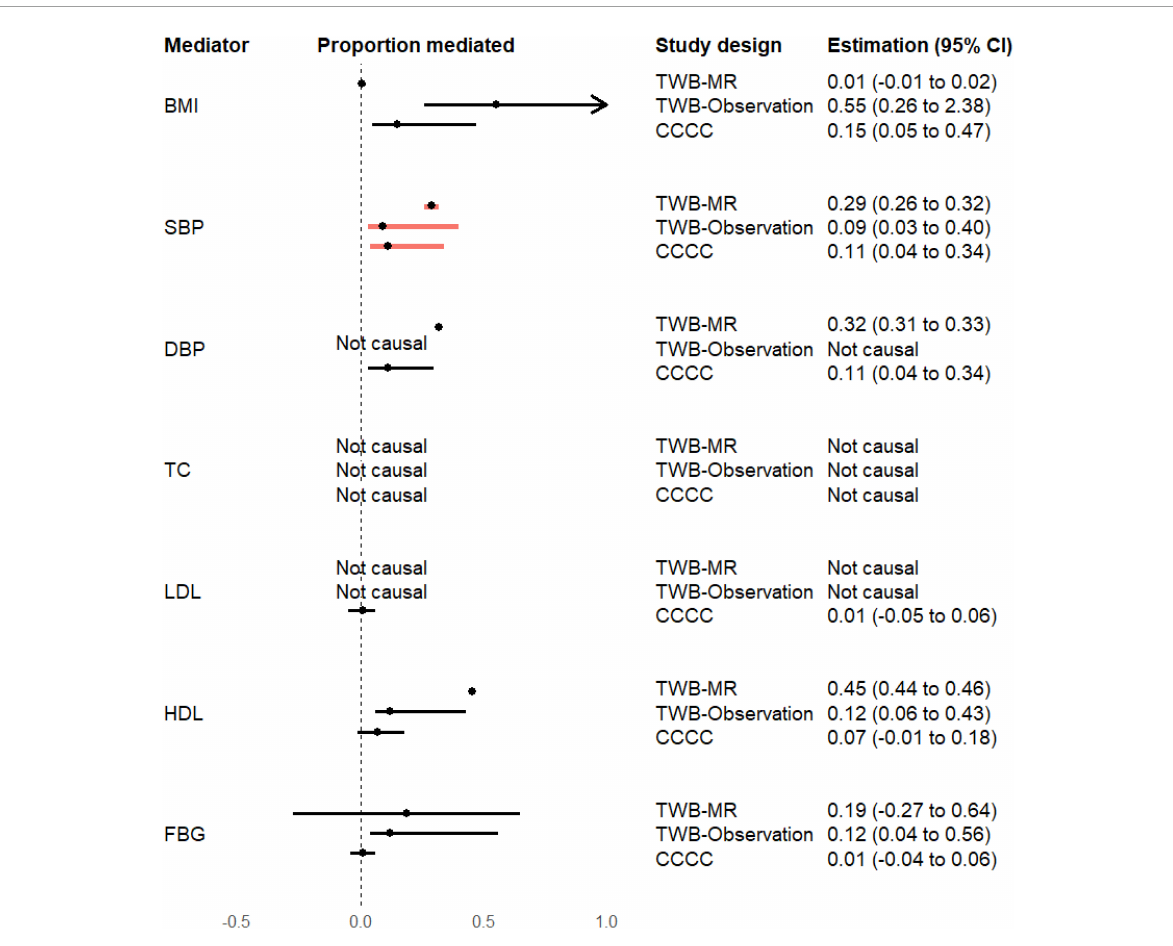
FIGURE2 Proportion of the mediation effects of earlier age at menarche on the risk of coronary artery disease. BMI, body mass index; CCCC, the Chin-Shan Community Cardiovascular Cohort study; CI, confidence interval; DBP, diastolic blood pressure; FBG, fasting blood glucose; HDL, high-density lipoprotein cholesterol; LDL, low-density lipoprotein cholesterol; SBP, systolic blood pressure; TC, total cholesterol; TWB-MR, one-sample Mendelian randomization analysis in the Taiwan Biobank study; TWB-Observation, regression analysis in the Taiwan Biobank study. The proportion of mediation effect is defined as “not causal” if the total and indirect effects are in opposite